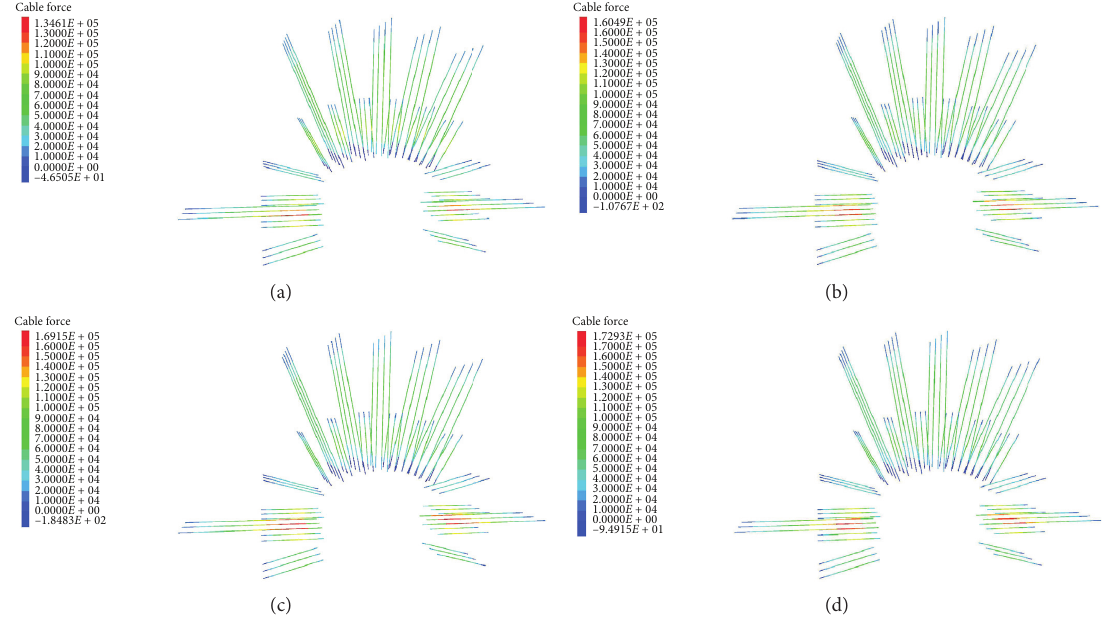
Figure 12: Cable stress distribution under different excavation distance with surrounding rock grouting. (a) Excavate 3m. (b) Excavate 6m. (c) Excavate 9m. (d) Excavate12m.